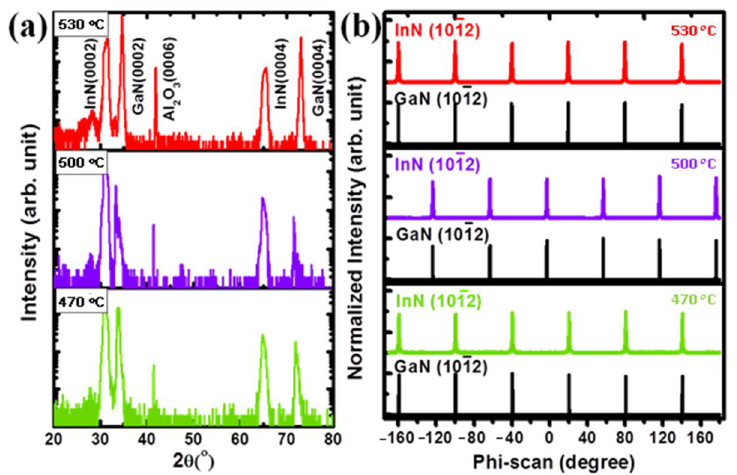
Figure 2. ( a ) XRD patterns of InN nanorods and films deposited on a GaN template. ( b ) Phi-scan patterns in XRD of InN(1012) phi-scan of nanorods and films.